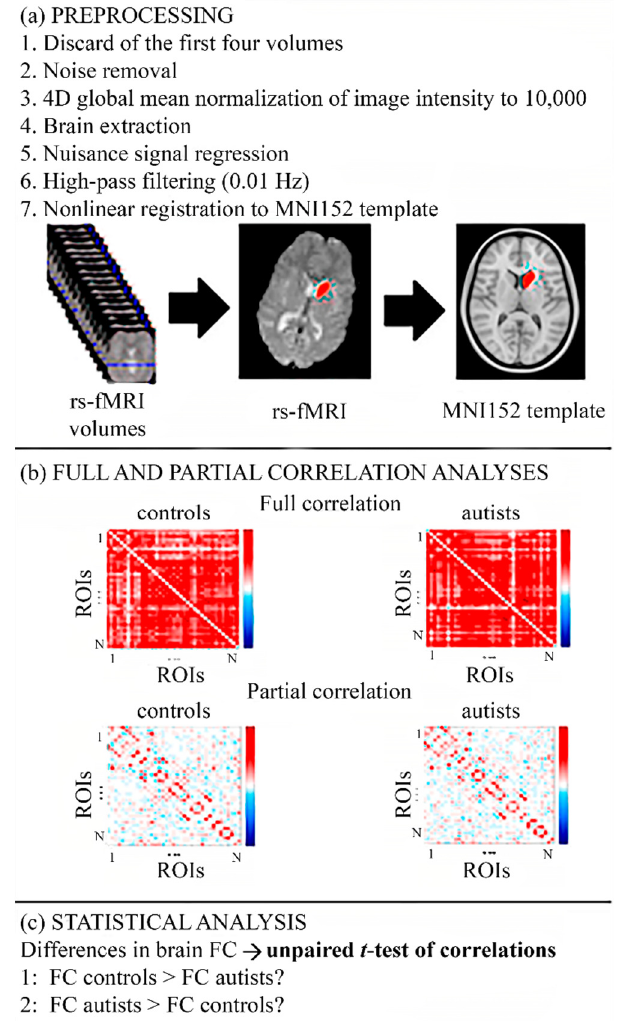
Figure 1. Flowchart of the methodology to compare functional connectivity in controls and autists. ( a ) Preprocessing steps for the rs-fMRI images. ( b ) Full and partial correlation analyses. Correlation indicates the amount of statistical dependence between two anatomical regions. Full correlation measures the amount of FC—statistical dependence—between two directly or indirectly connected regions, whereas the partial correlation focuses on direct connections. ( c ) Statistical analysis with two contrasts: (1) FC between two regions is higher in controls than in autists, (2) FC between a pair of regions is greater in autists than in controls. FC: functional connectivity; ROIs: regions of interest; rs-fMRI: resting-state functional magnetic resonance